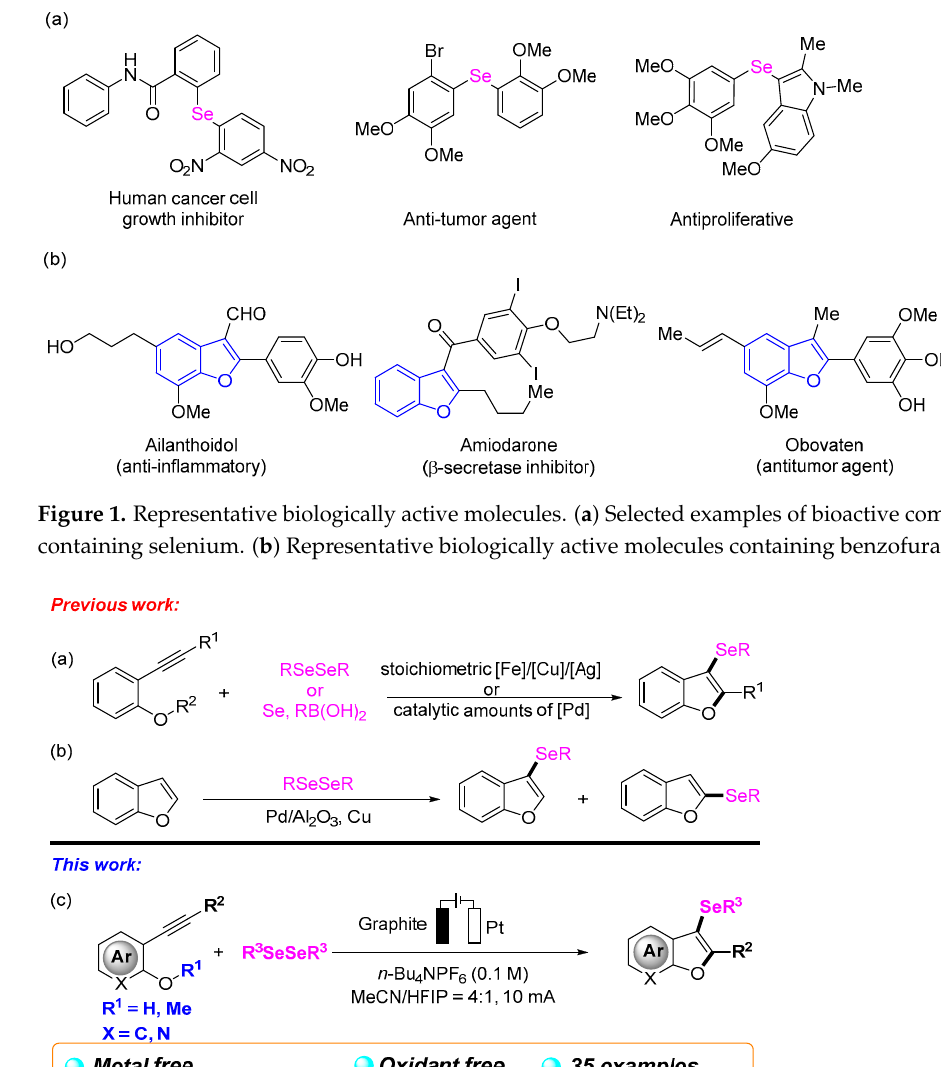
Figure 1. Representative biologically active molecules. ( a ) Selected examples of bioactive com- pounds containing selenium. ( b ) Representative biologically active molecules containing benzo- furan